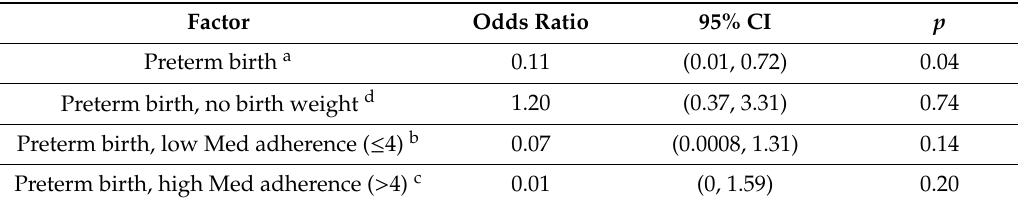
Table 4. Odds ratio and 95% confidence intervals of the association between elevated prenatal cadmium exposure and preterm